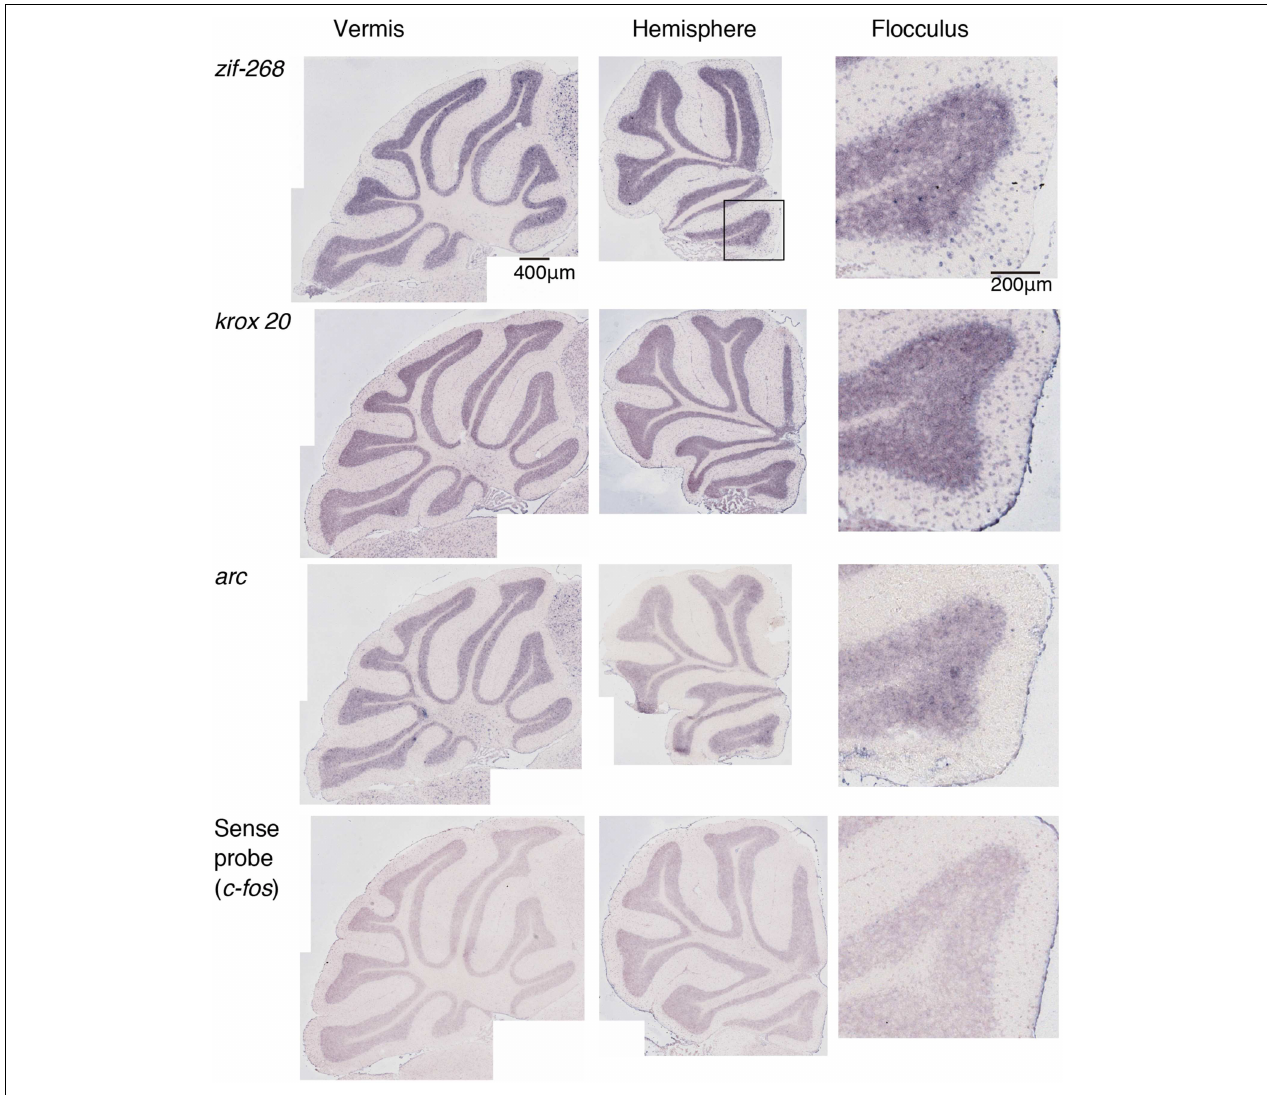
The figures are lined up in the same order as in Figure 2 . The last (4th) row shows the signals hybridized with a sense probe of c-fos , indicating the background